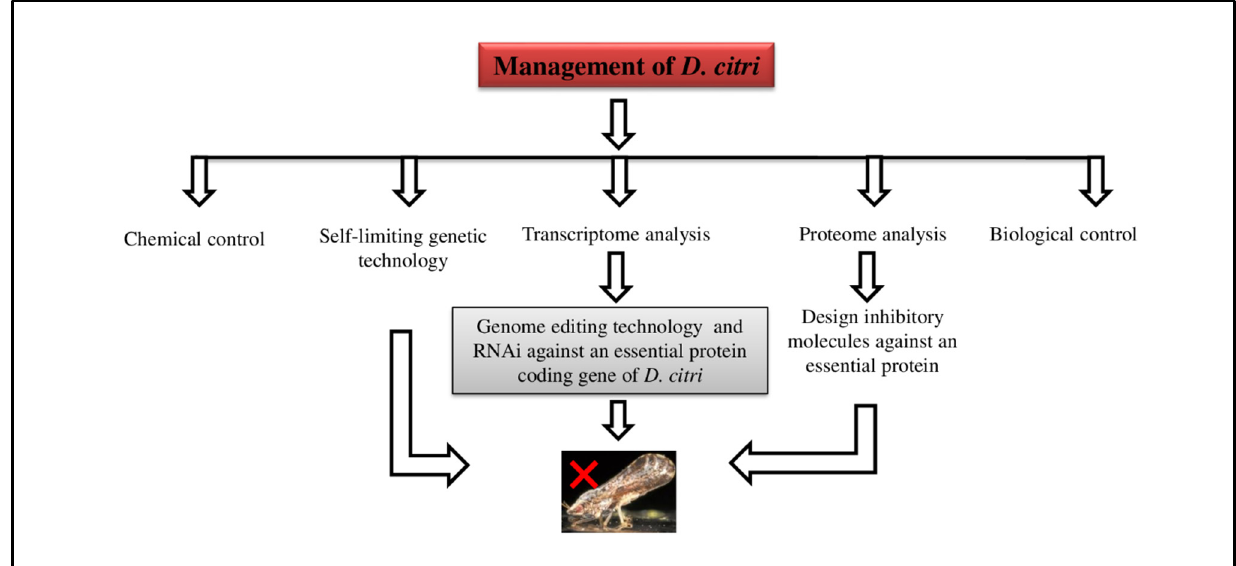
Figure 11. Different strategies to manage the ACP population.